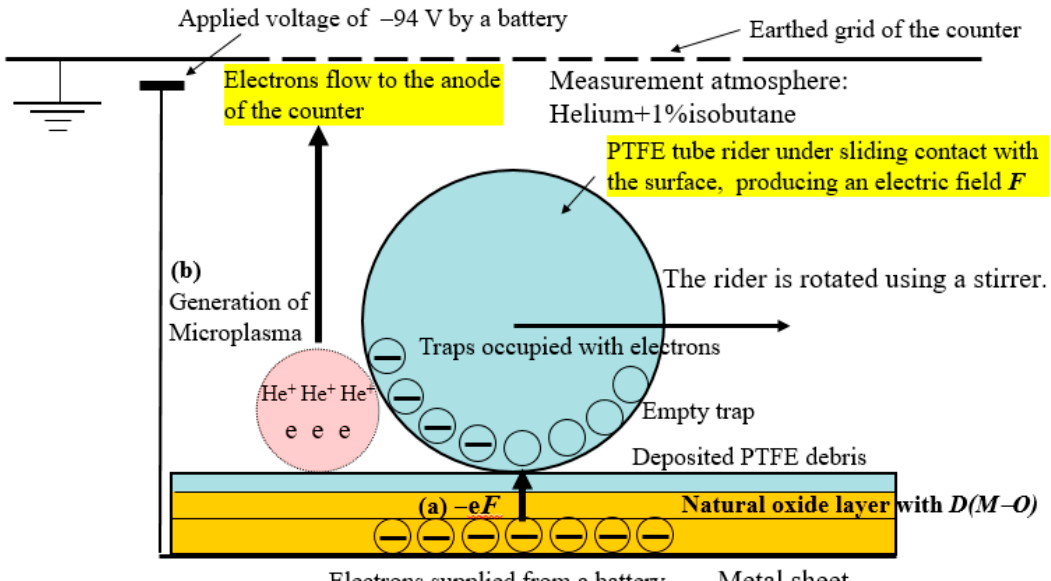
Figure 20. The relationship between triboelectron emission from a metal sample covered with a natural oxide layer of D(M–O) occurring during sliding process by a PTFE rider and the formation of electric fields: ( a ) a force, − e F , exerted on an electron by an electric field, F , between a metal surface and a PTFE rider; ( b ) flow of electrons from microplasma produced by separation-induced electric field; applied voltage to accumulate electrons.